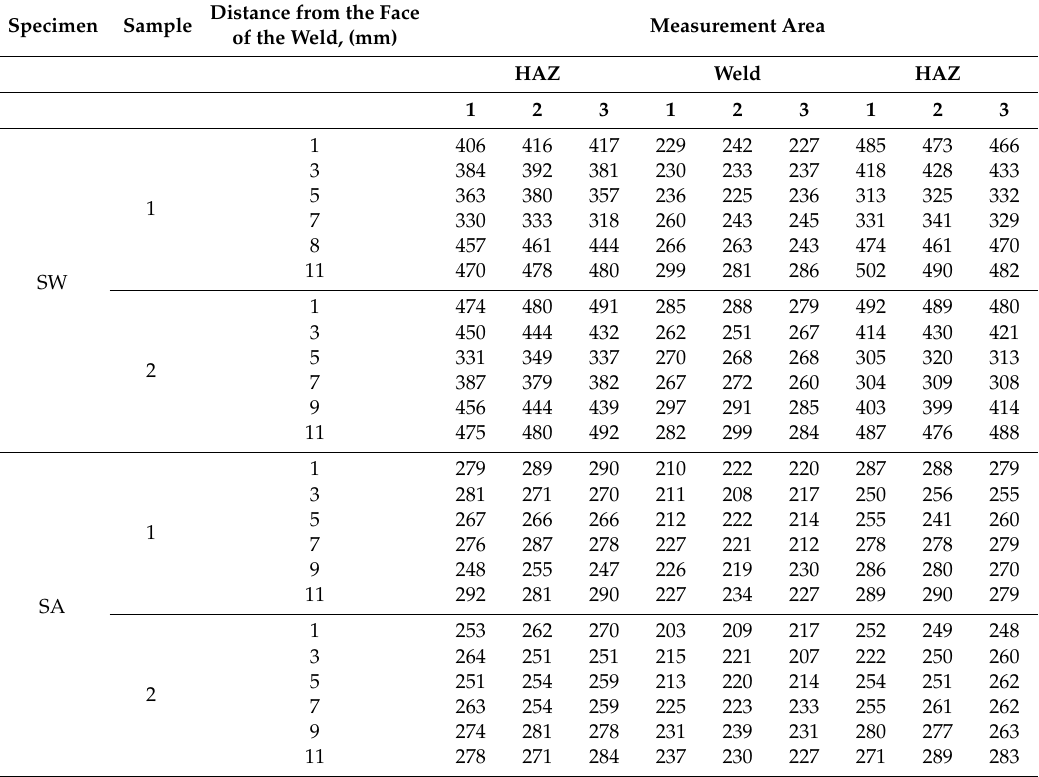
Table 7. Results of hardness Vickers HV10